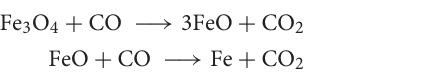
Frontiers in Chemistry |